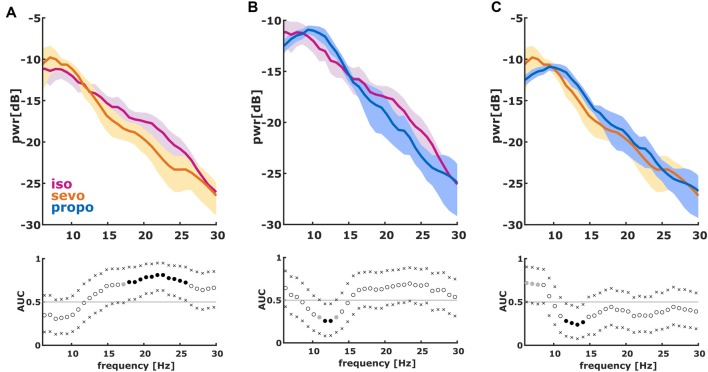
Normalized PSD (nPSD) in the 6–30 Hz range of the first 2 s of the first burst. (We dismissed the first 100 ms of burst onset to make sure we did not include any suppression). The solid lines present the median and the shaded areas the median absolute deviation for the comparisons of (A) isoflurane and sevoflurane, (B) isoflurane and propofol and (C) sevoflurane and propofol. In the AUC plots, a filled circle in black indicates significance and a gray circle indicates a non-significant AUC > 0.7. The non-filled circles indicate AUC < 0.7 with 95% CIs inclusive 0.5, i.e., there is no effect. The x indicate the upper and lower limits of the 95% Ci.